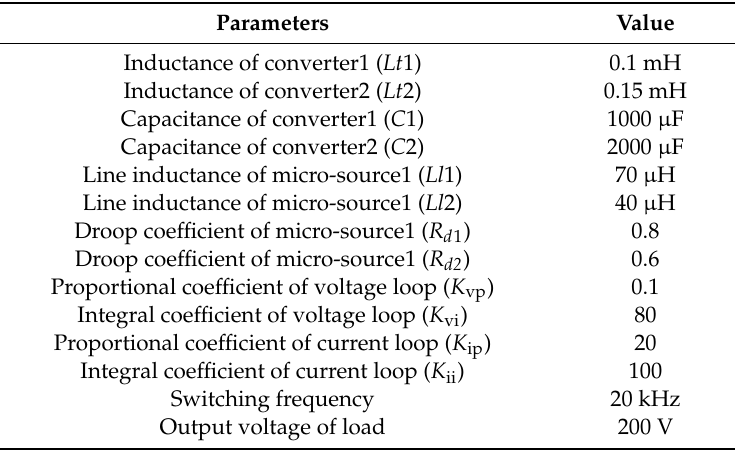
Figure 6. Simulation model of the DC microgrid. Table 1. Parameters of the simulation model.